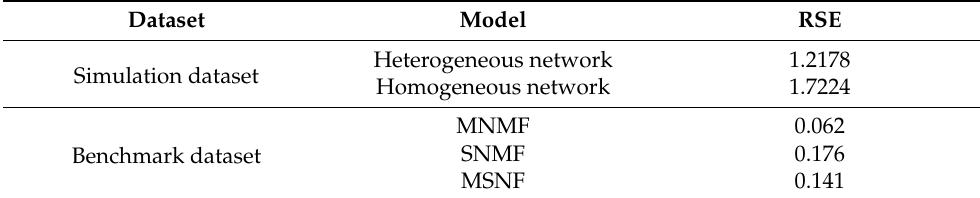
Table 7. Prediction loss of different models on the two datasets.